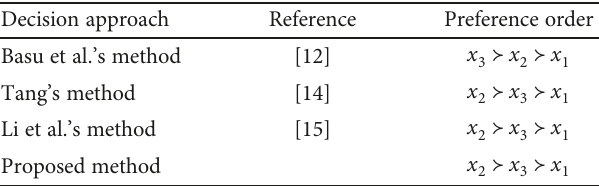
Table 10: A comparison of the preference orders of the alternatives for di ff erent